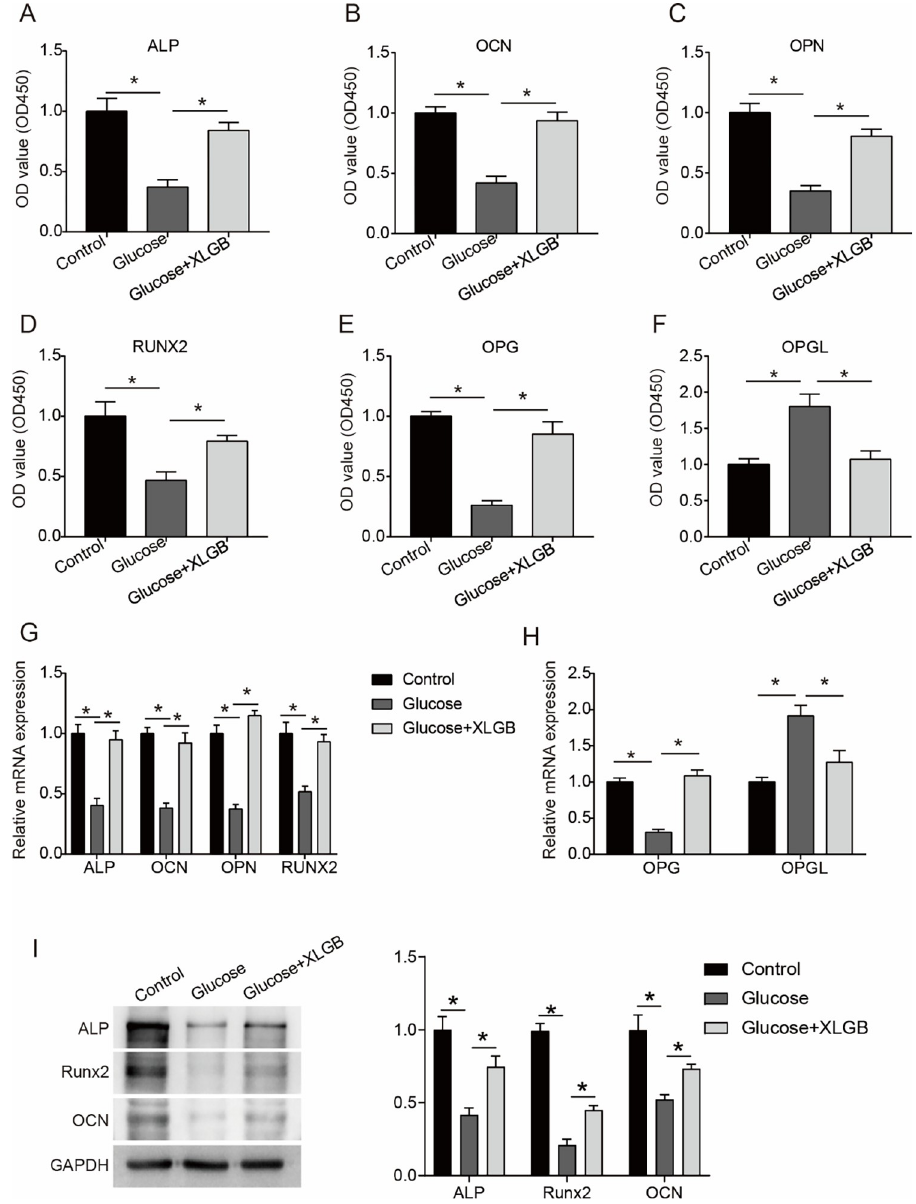
Fig 4. XLGB rescues the reduced osteogenic differentiation-associated markers in the MG63 cells exposed to high glucose. A-F. The protein levels of ALP (A), OCN (B), OPN (C), RUNX2 (D), OPG (E), and OPGL (F) were examined using ELISA assay in the MG63 cells incubated in control, high glucose and high glucose +XLGB mediums. G. The mRNA levels of ALP, OCN, OPN, and RUNX2 were examined by RT-PCR analysis in MG63 cells after indicated treatment. H. The mRNA levels of OPG and OPGL in MG63 cells. I. the levels of osteogenesis differentiation- associated markers were determined by western blot. Control, cells treated with mannitol; Glucose, cells treated with 20 mM of glucose; Glucose +XLGB, cells treated with 20 mM of glucose plus 200 mg/L of XLGB. Data represented mean ± SD of three separate experiments. � P < 0.05.